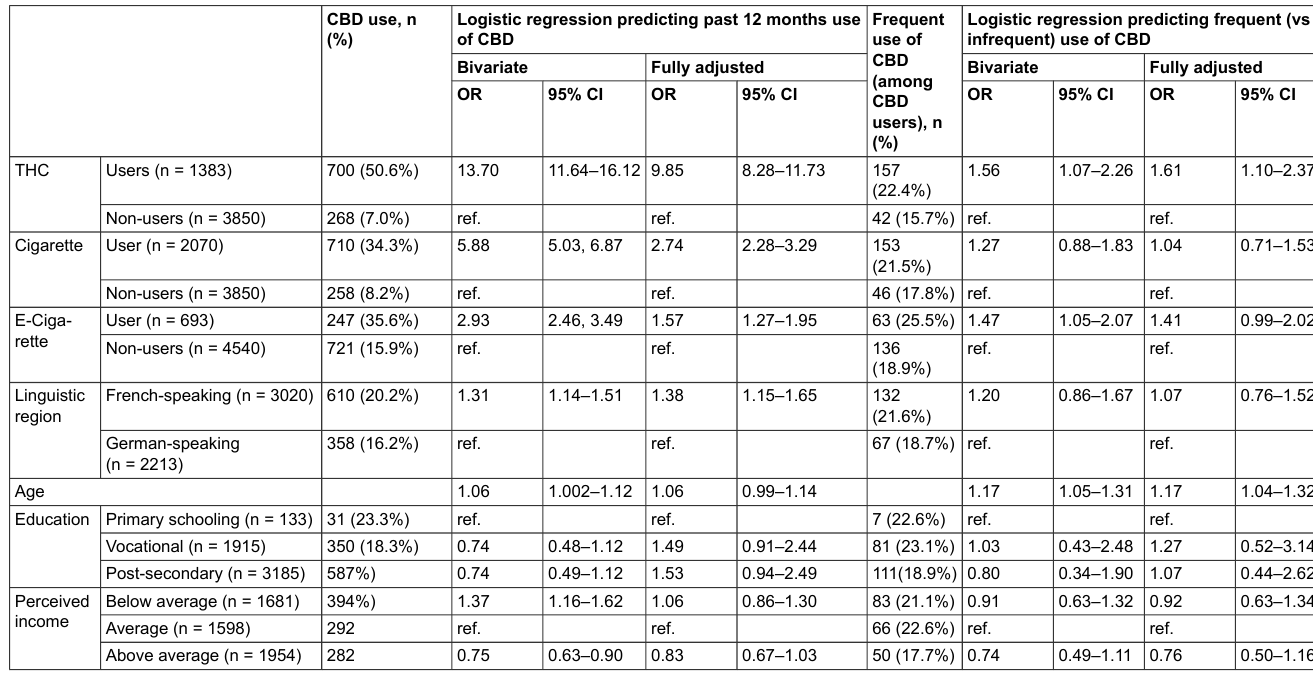
Table 4: Associations between CBD use and demographics and other substance